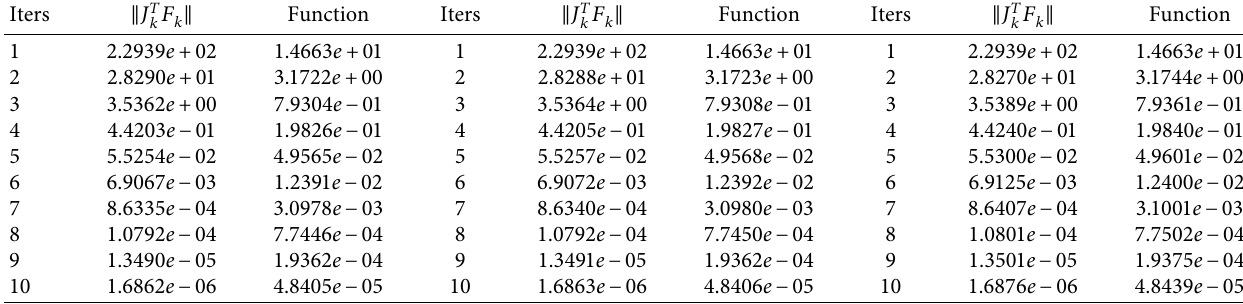
� ( 1 , − 3 , 0 , 1 ) T , stopping criterion ‖ J T 0